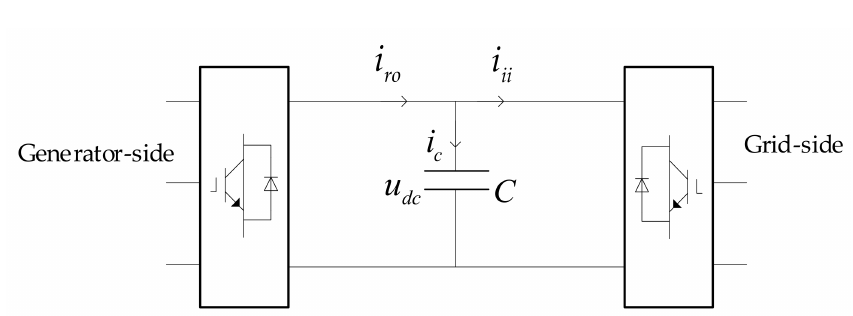
Figure 5. Sketch diagram of the converter in PMSWT